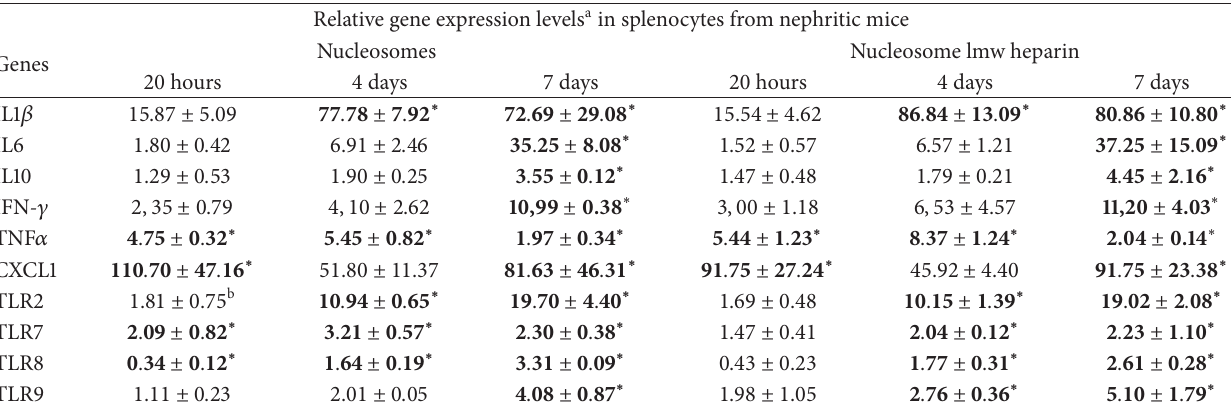
Table 2: Transcriptional levels of cytokines and Toll-like receptors in stimulated splenocytes. Relative gene expression levels a in splenocytes from nephritic